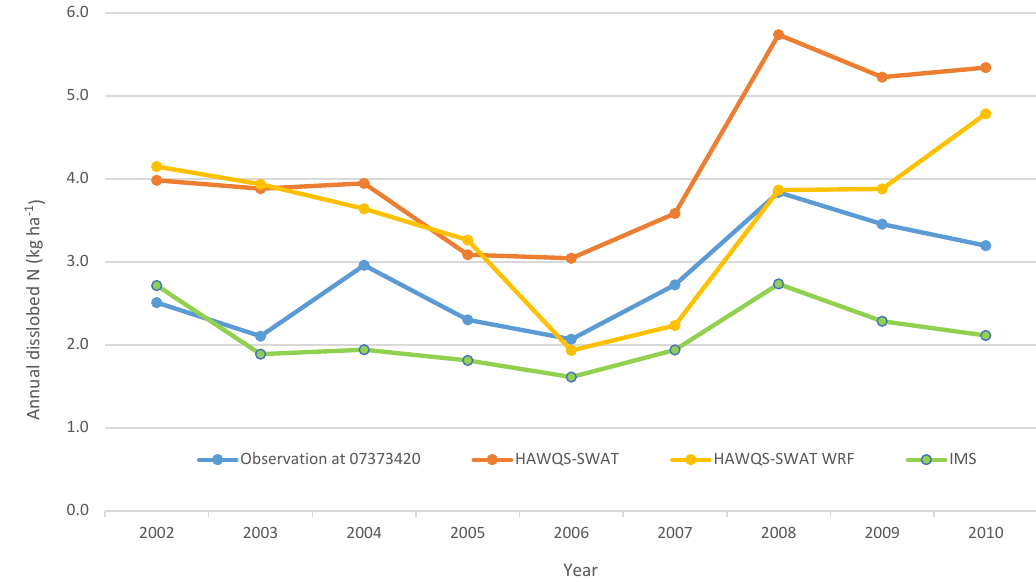
Figure 8. Annual dissolved N evaluation at the total outlet of the MRB (USGS 07373420).